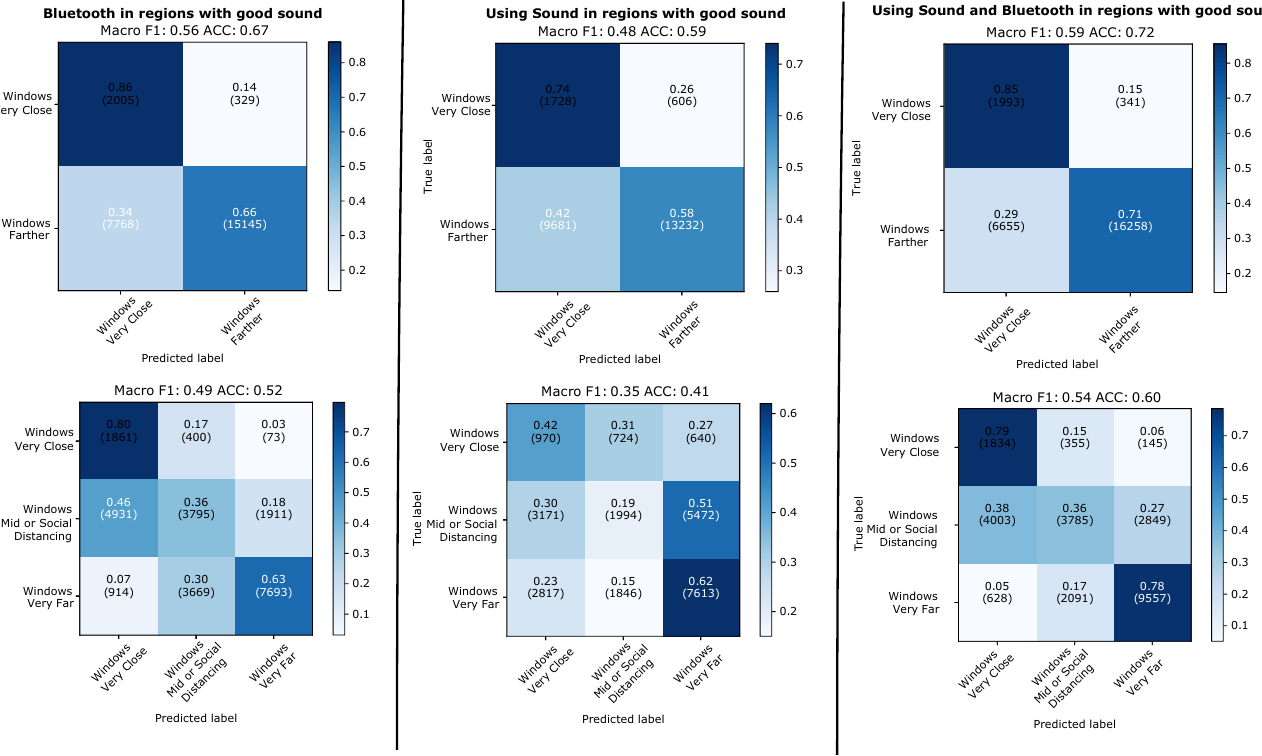
Figure 14. Evaluation across types of days. Results for evaluation when predicting individual 5 s windows with good